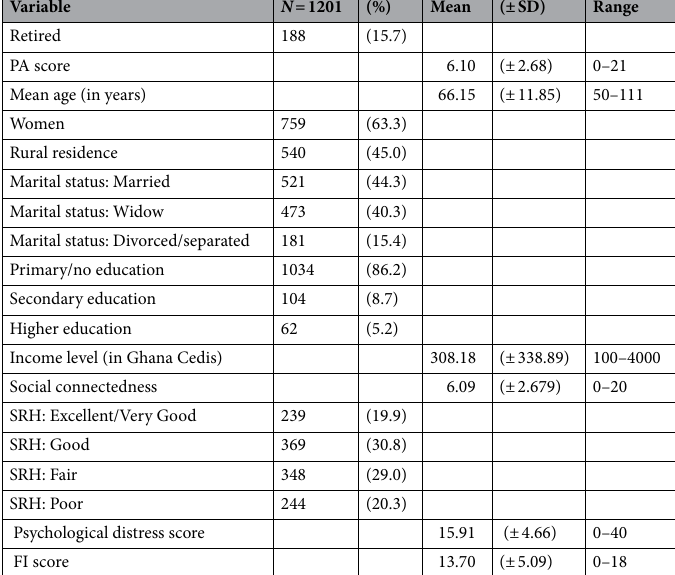
Table 1. Characteristics of the sample. FI—functional impairment; AP—physical activity; SRH—self-rated health; a Exchange rate: $1 ∼ ¢4.8 as of the time of data